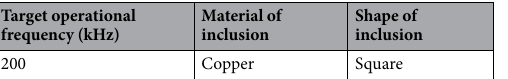
Table 2. Specified design conditions for a DZIPnC with a hard